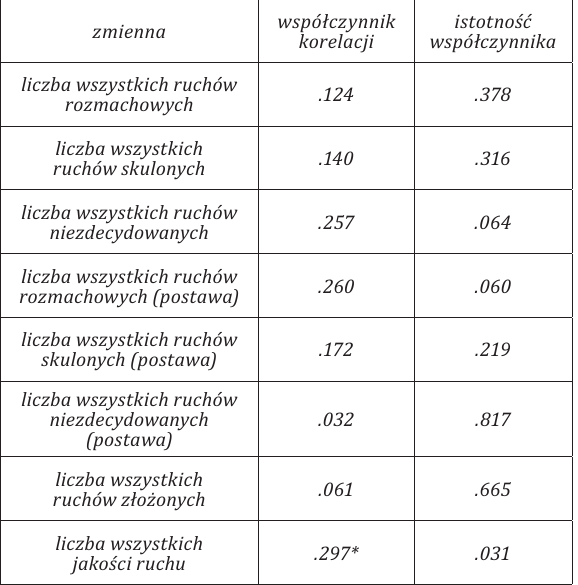
Tabela 9. Wartości rho Spearmana między zmienną „światłocienie” a zmiennymi dotyczącymi jakości